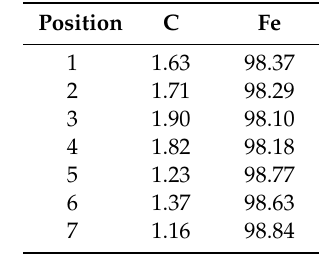
Table 1. Energy Dispersive Spectrometer (EDS) analysis of the tube normal microstructure in Figure 9a (mass fraction/%).